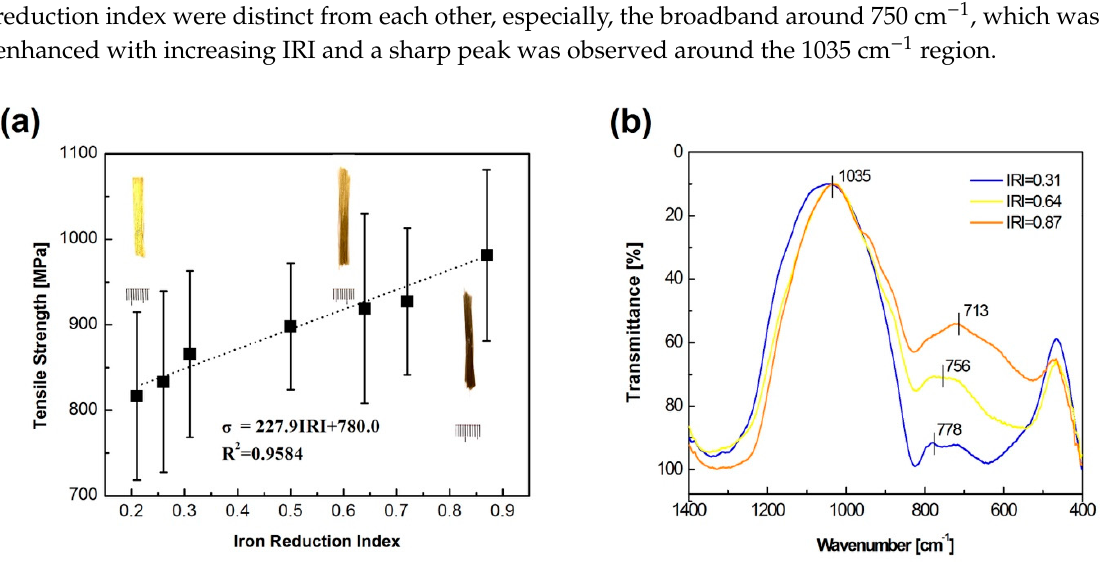
Figure 2. ( a ) Tensile strength of basalt fiber samples; ( b ) FT-IR absorption spectra of basalt fiber samples.